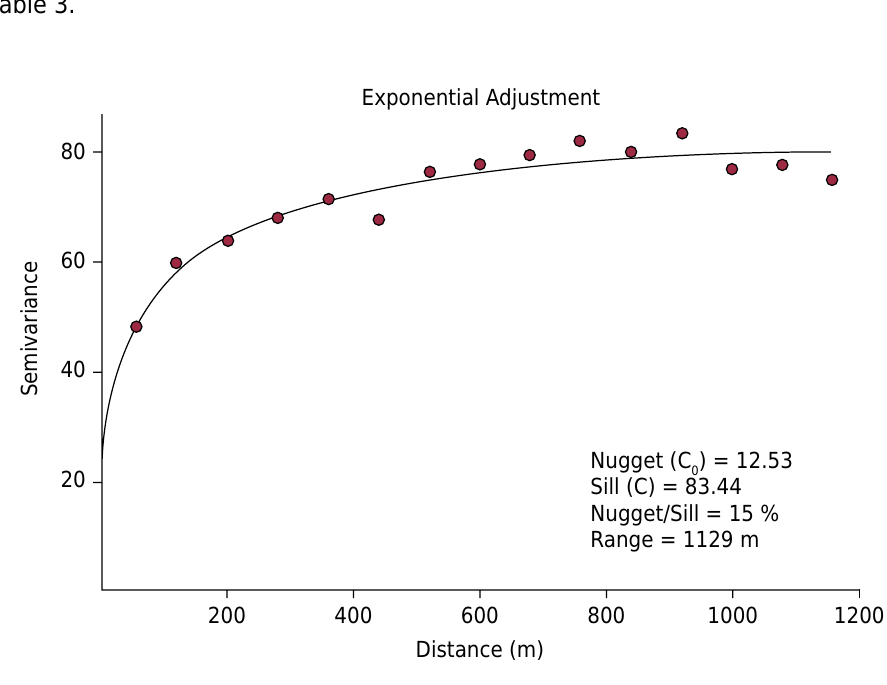
Figure 3. Semivariogram of cation exchange capacity obtained by